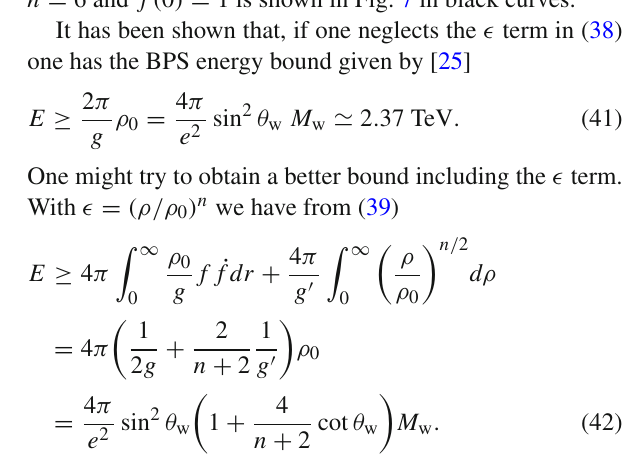
5 BPS electroweak